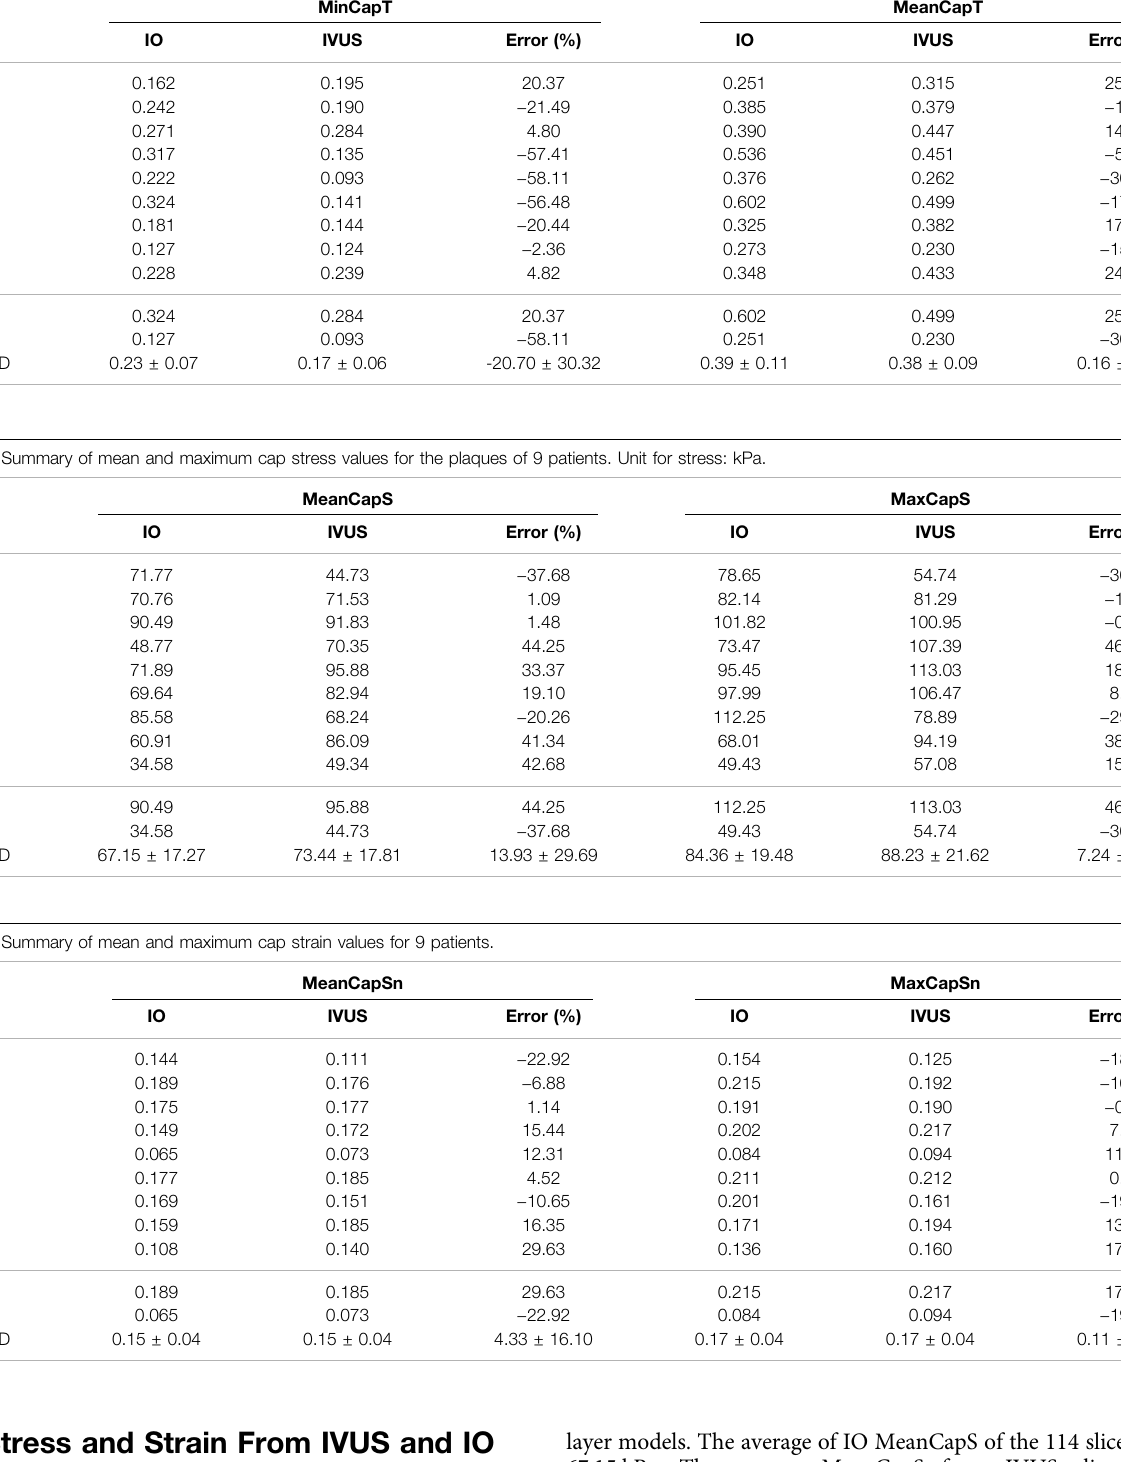
average. Patient variations of the individual errors for